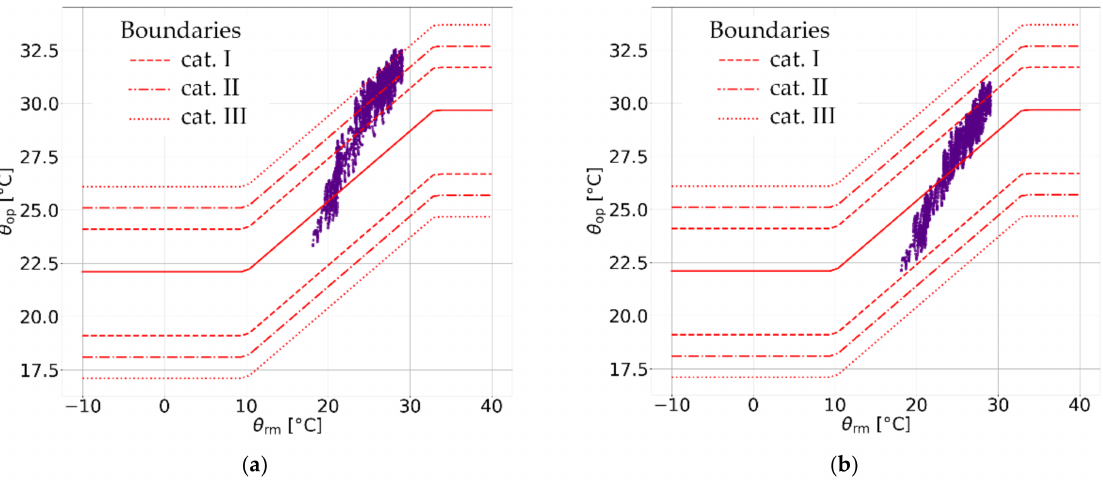
Figure 12. Distribution of datapoints in adaptive comfort categories for ( a ) worst and ( b ) best free-running summer modes in Rome. Dashed and dotted lines represent adaptive comfort categories’ boundaries.